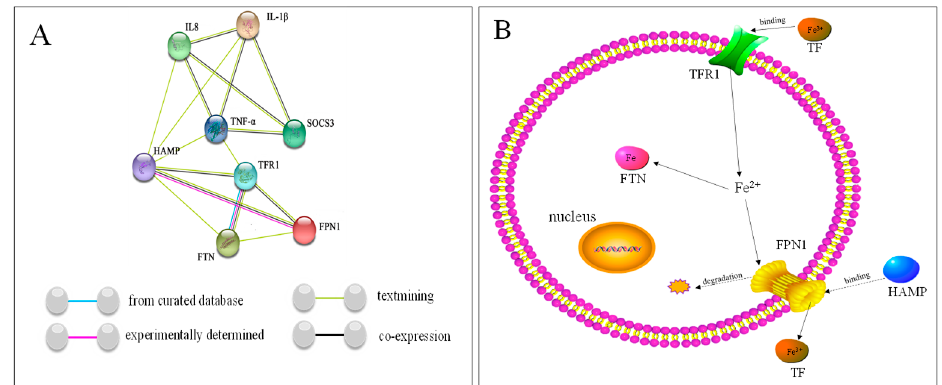
Mutated-type Appendix Figure A1. Structure prediction of the Sc-hep protein. ( A ): Protein structure of the precursor Sc-hep. The yellow region is the signal peptide with an α -helix structure. The purple region is the propeptide